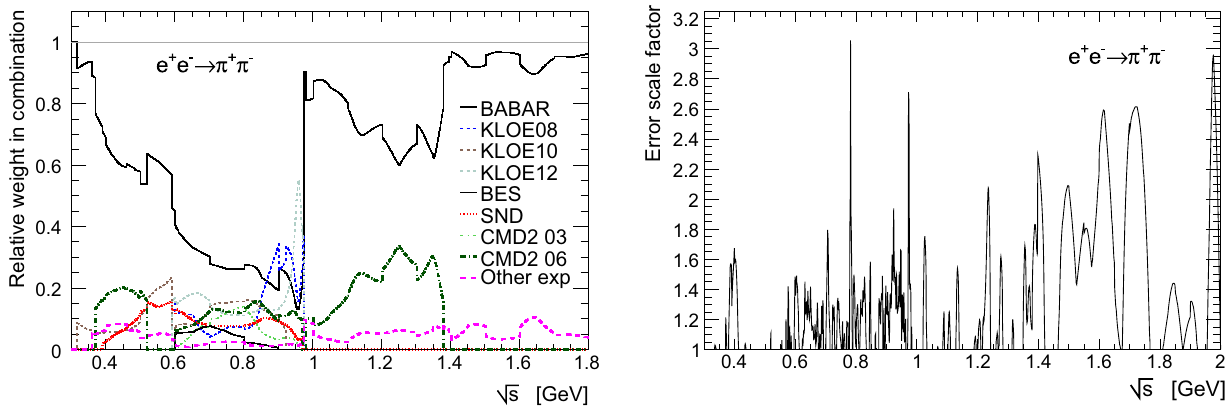
[GeV]s Fig. 3 Left relative local weight per experiment contributing to the e + e − → π + π − cross-section combination versus centre-of-mass energy. Right local scale factor versus centre-of-mass energy applied to the combined π + π − cross-section uncertainty to account for inconsistency in the individual